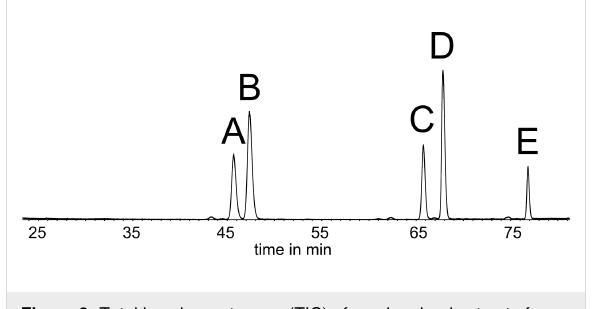
Figure 3: Total ion chromatogram (TIC) of a gular gland extract of Hyperolius cinnamomeoventris on a polar DB-wax GC phase. A , C : sesquiterpenes; B : cinnamomeoventrolide; D : ( Z )-tetradec-5-en-13- olide; E :